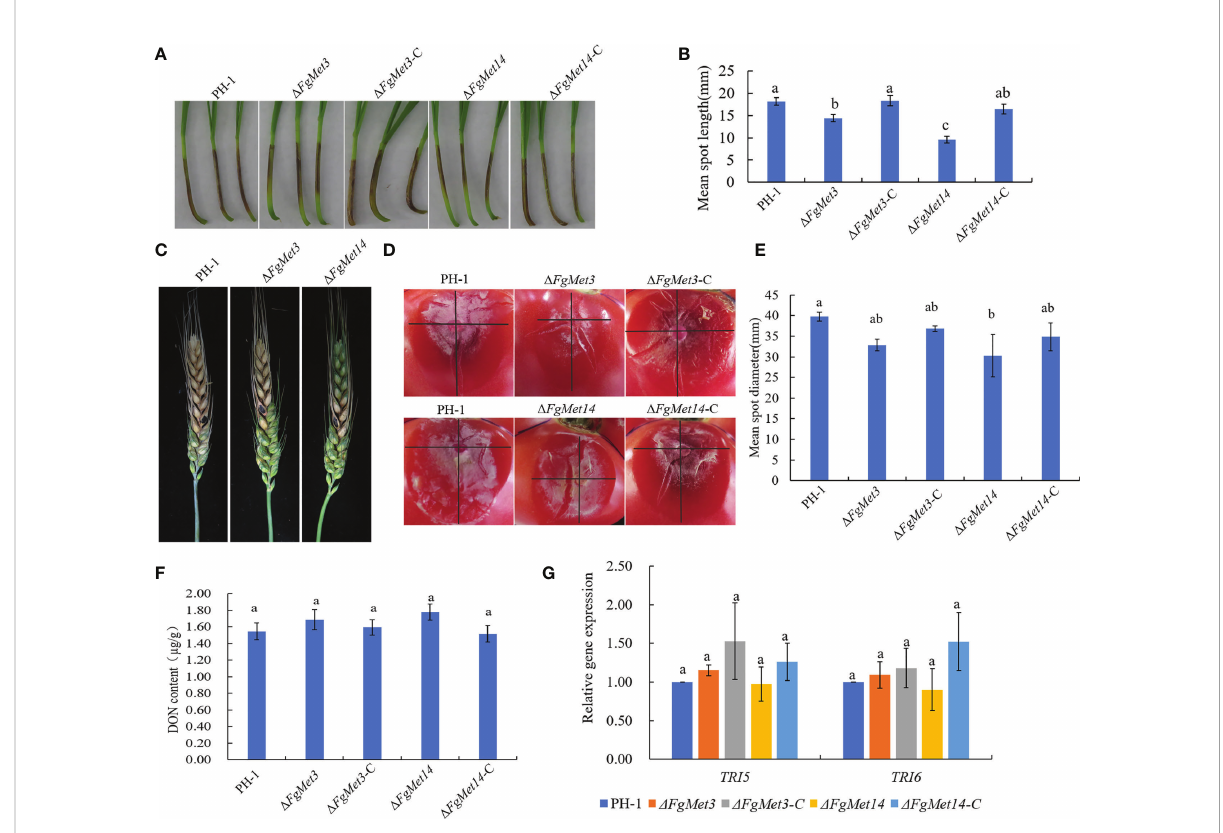
FIGURE 9 Defects of D FgMet3 and D FgMet14 mutants in plant infection. (A) Wheat coleoptiles were examined at 10 days after inoculated with a conidial suspension. (B) Mean spot length of the strains. Bars with the same letter indicate no signi fi cant difference at p = 0.05. (C) Flowering wheat heads were examined at 14 days post-inoculation (dpi). The inoculation sites were indicated by black dots. (D, E) The tomato mean spot diameter were examined at 3 days after placed with fresh dishes. (F) FgMet3 and FgMet14 are not important for DON biosynthesis of Fusarium graminearum . All strains were incubated in GYEP for 7 days and mycelia were harvested and dry for weighing. (G) FgMet3 and FgMet14 didn ’ t regulate TRI5, TRI6 gene expression in Fusarium graminearum . All strains were incubated in GYEP for 36 h and mycelia were harvested for qRT- PCR. Bars with the same letter indicate no signi fi cant difference according to the least signi fi cant difference (LSD) test at p =